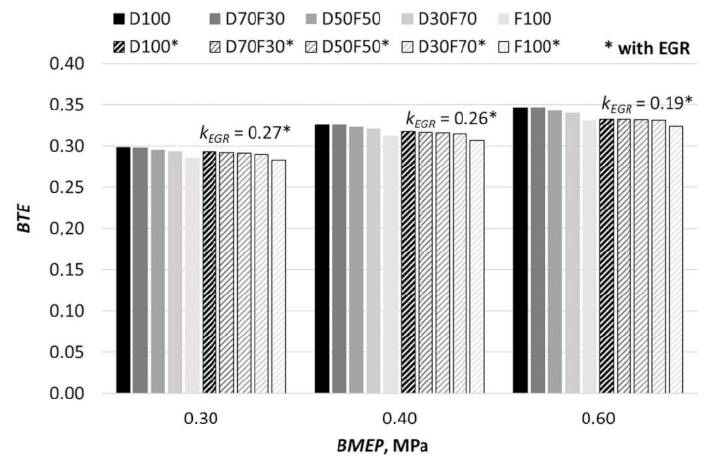
Figure 12. Dependence of brake thermal efficiency on fuel composition and the engine